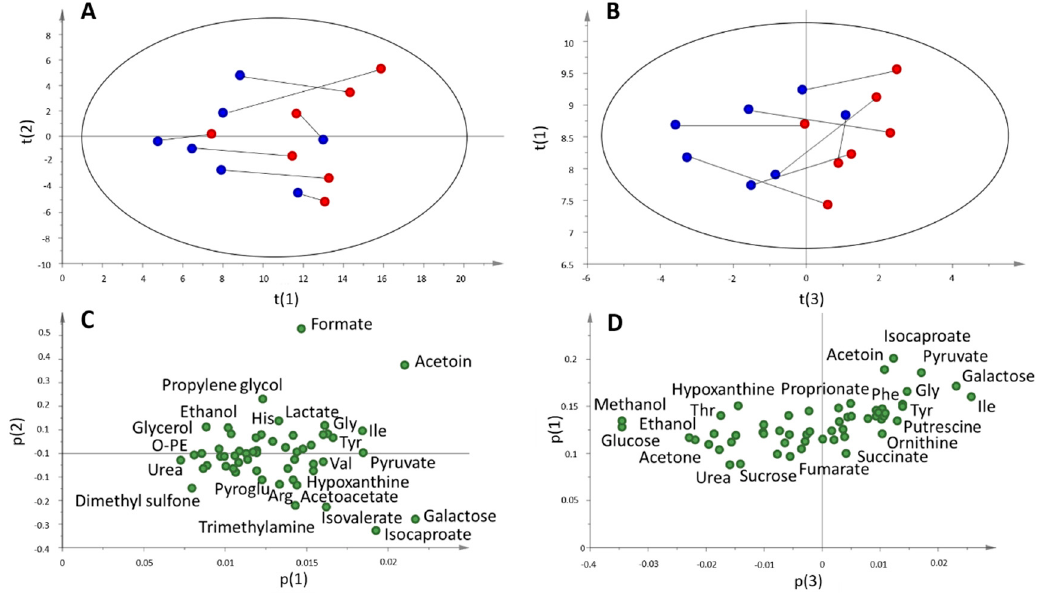
Figure 5. ( A ) Score plot and ( C ) loading plot for the PCA analysis of pre (blue) and post-samples (red) of the game group (n = 7) using TPWS normalization. The lines connect samples belonging to the same subject ( B ) Score plot and ( D ) loading plot for the PCA analysis of pre (blue) and post-samples (red) of the game group (n = 7) using TOMC-normalized data. Abbreviations: Arg, arginine, Gly, glycine, His, Histidine, Ile, isoleucine, O-PE, o-phosphoethanolamine, Phe, phenylalanine, Thr, threonine, Tyr, tyrosine, Val, valine.